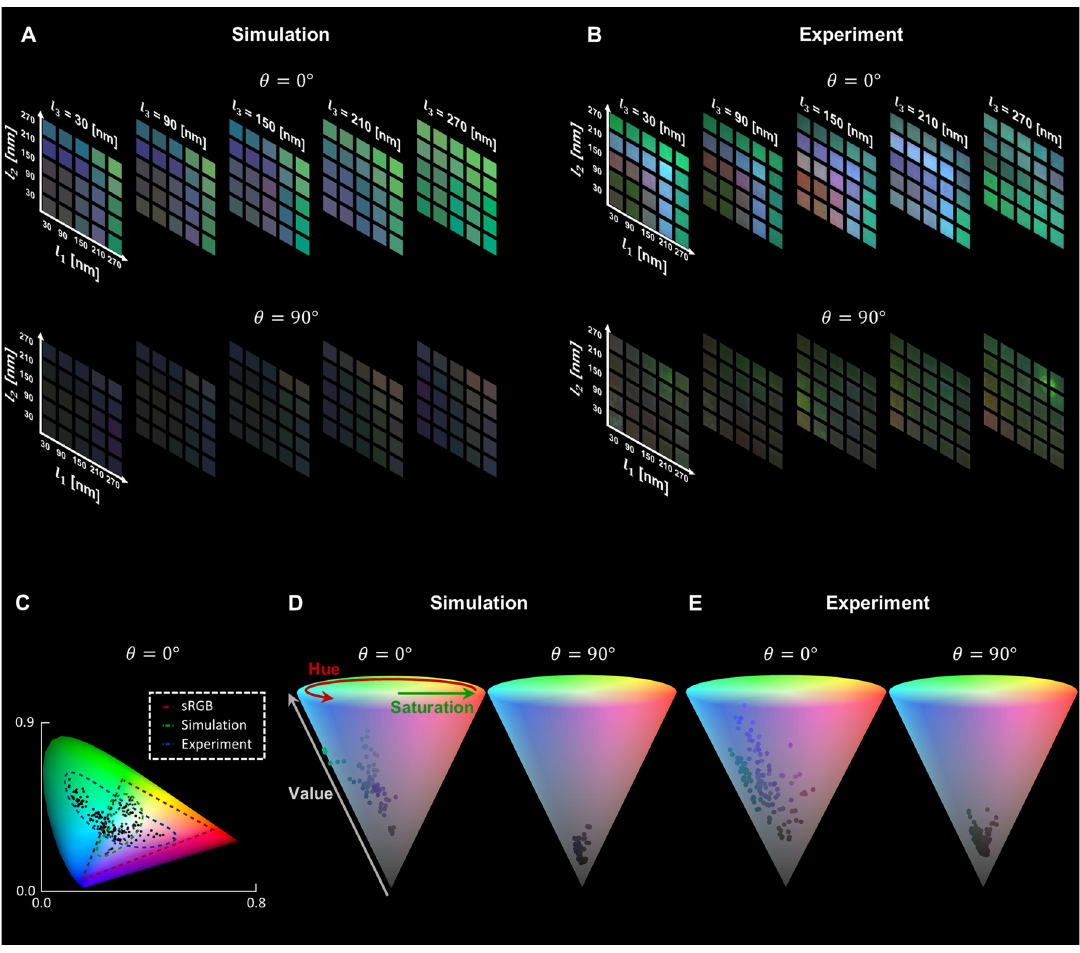
Figure 2: Numerically simulated and experimentally measured colors where P = 900 nm, h = 250 nm, w = 50 nm, and d = 50 nm. (A) Numerically calculated color palettes at θ = 0 ° (top) and θ = 90 ° (bottom). (B) Experimentally measured color palettes at θ = 0 ° (top) and θ = 90 ° (bottom). (C) Simulated (green dashed line), and experimental results (blue dashed line) plotted on the CIE 1931 chromaticity diagram at θ = 0 ° . The colors are represented in the HSV color space for (D) simulated and (E) experimental results at θ = 0 ° and θ = 90 °